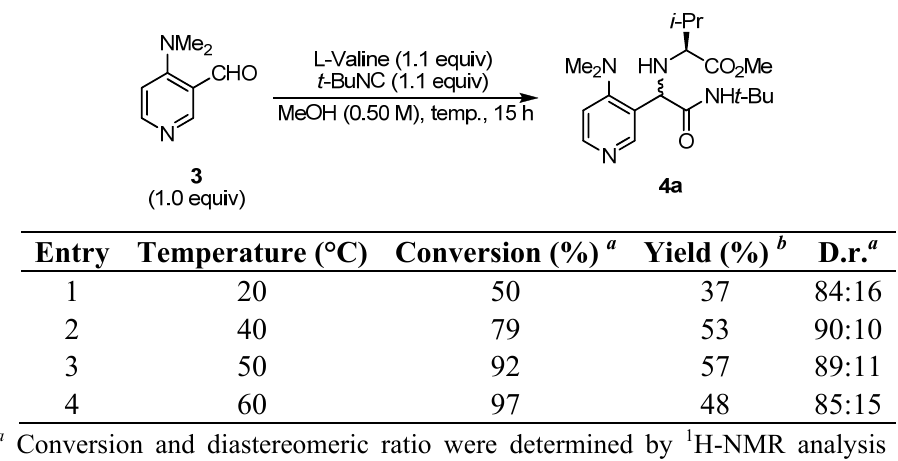
Table 3. Ugi reaction of 3 at various reaction